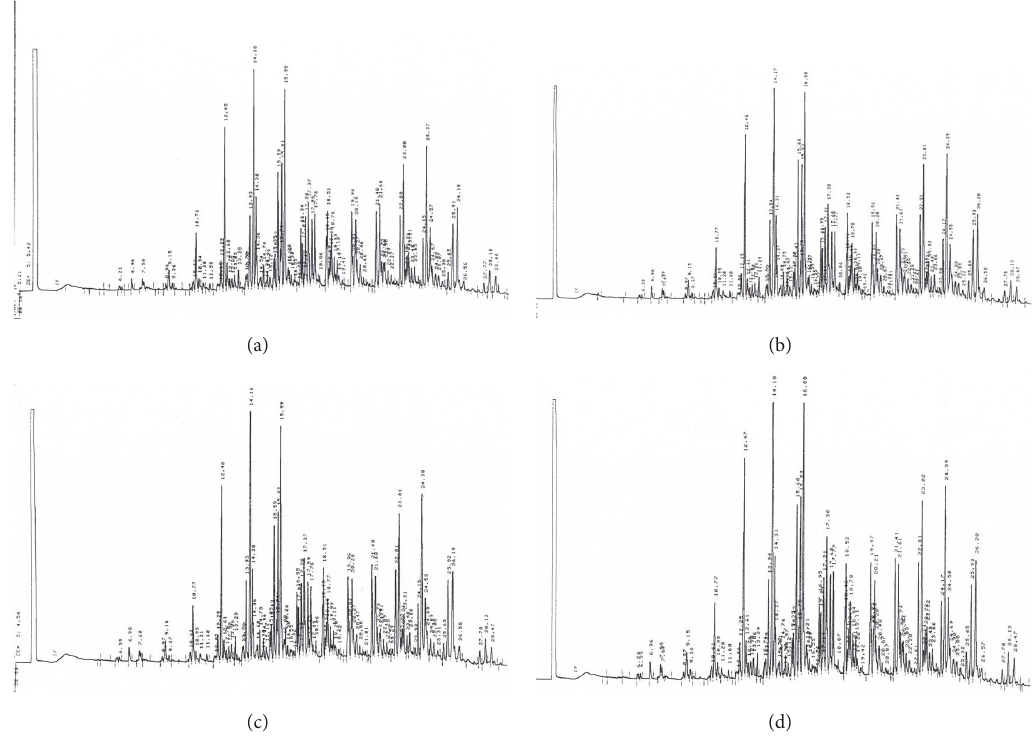
Figure 5: (a) Triglyceride profile of standard butter EEC (BCR 164); (b) triglyceride profile of Italian butter; (c) triglyceride profile of French butter; and (d) triglyceride profile of Dutch